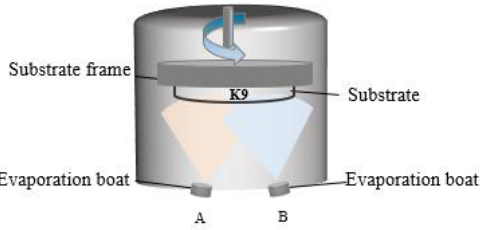
Figure 2. Schematic diagram of thermal evaporation of resistance.